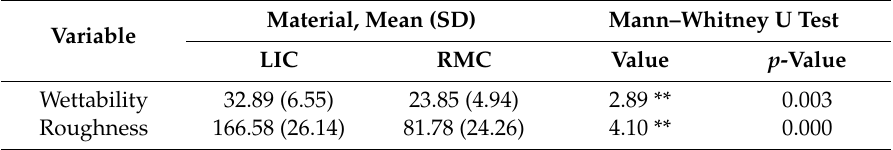
Table 6. Intergroup inferential analysis for the wettability and roughness parameters, depending on the type of material, with plasma activation surface